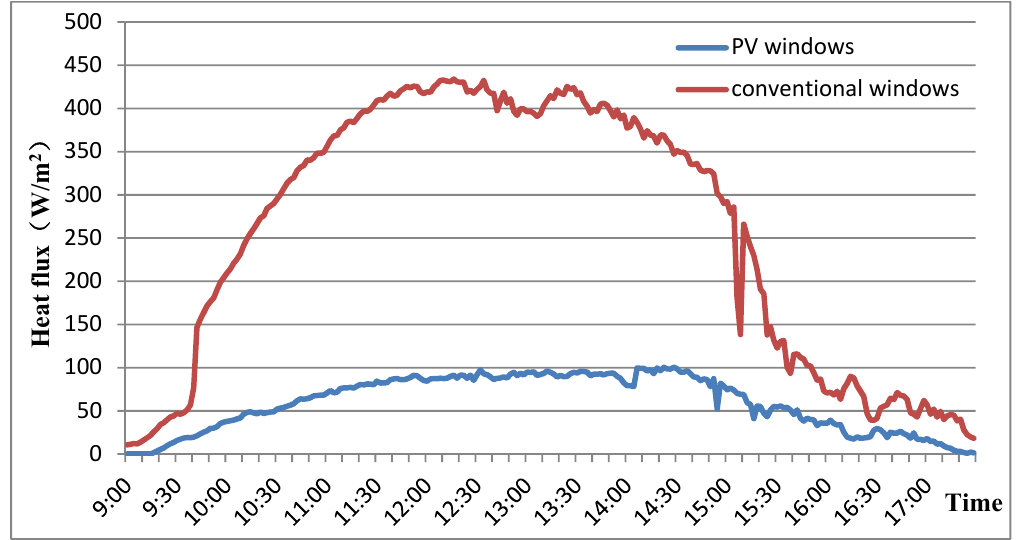
Figure 11. Heat flux through windows in 15 February 2018.